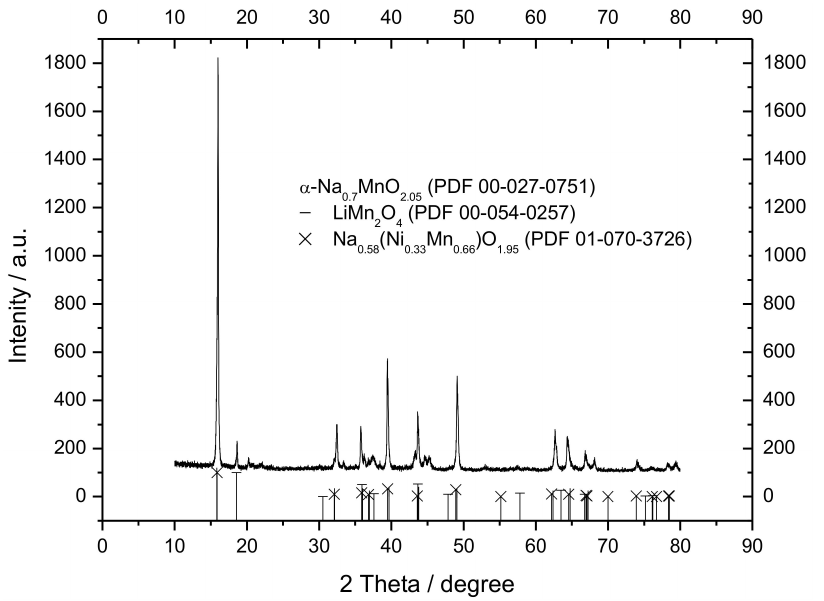
Figure 6. X-ray diffraction (XRD) patterns of the Na 1.0 Li 0.2 Ni 0.25 Mn 0.75 O δ . Black lines represent the position and intensity of the hexagonal P2-structure, space group P6 3 /mmc, of α -Na 0.70 MnO 2.05